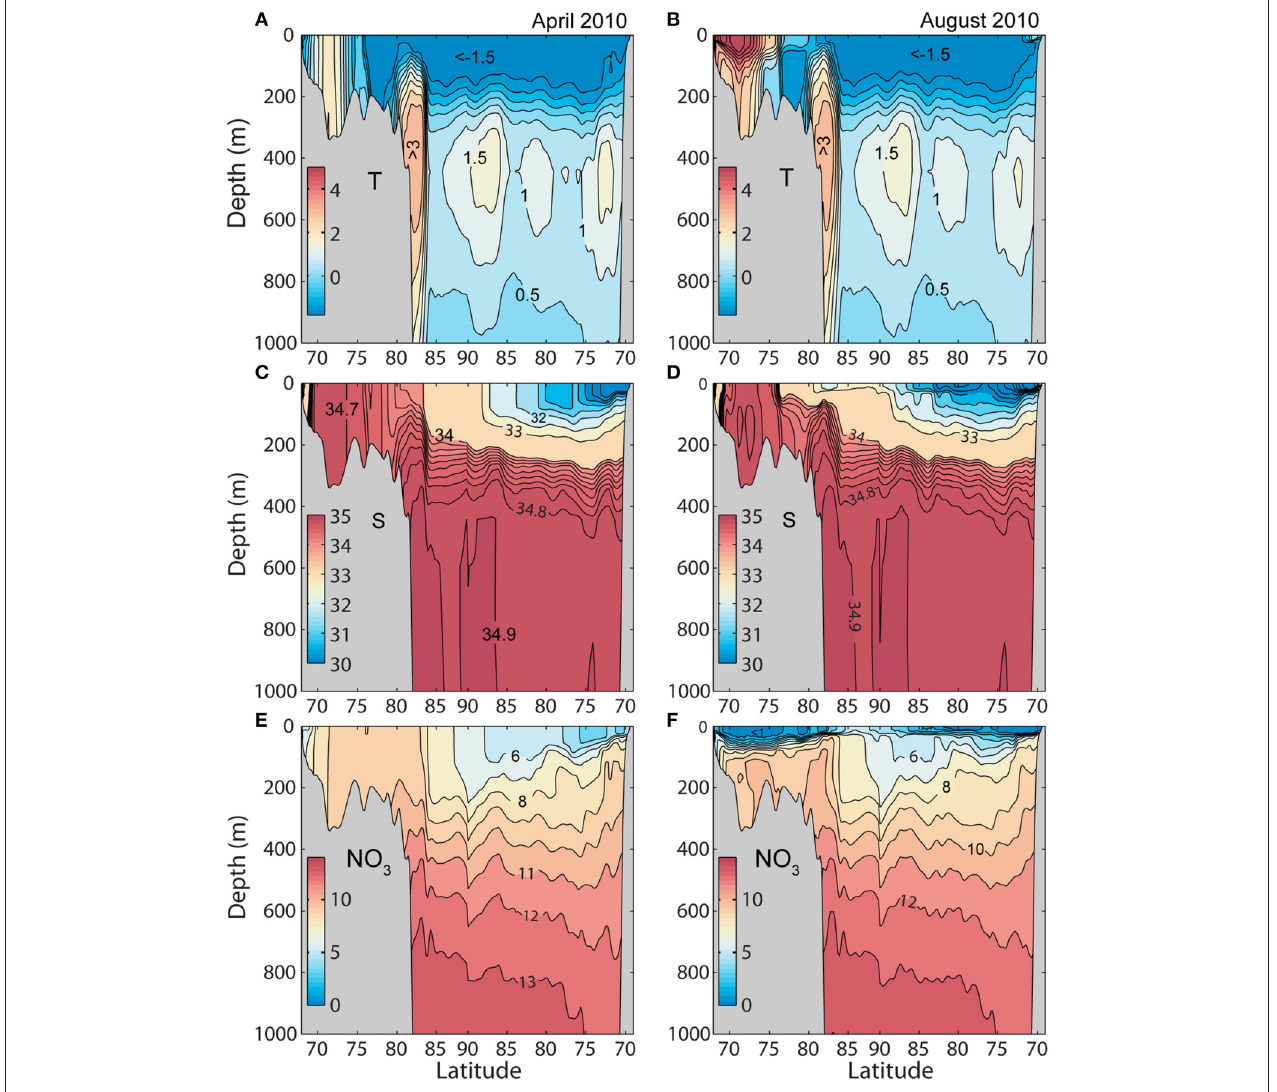
FIGURE 3 | Simulated monthly mean temperature ( ◦ C), salinity (psu), and nitrate (mmol N m − 3 ) along section A from the southern Barents Sea to the Beaufort Sea 2010 (see Figure 2), forced by ERA INTERIM (reanalyzed atmospheric fields). (A,C,E) April 13. (B,D,F) August 16.